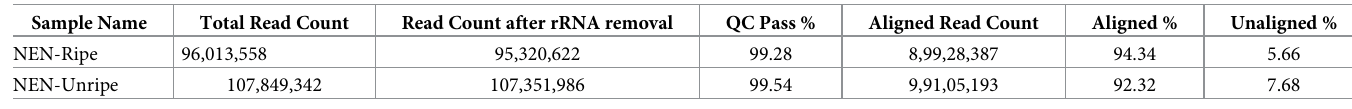
Table 1. RNA sequencing statistics of ripe and unripe banana cv. Nendran